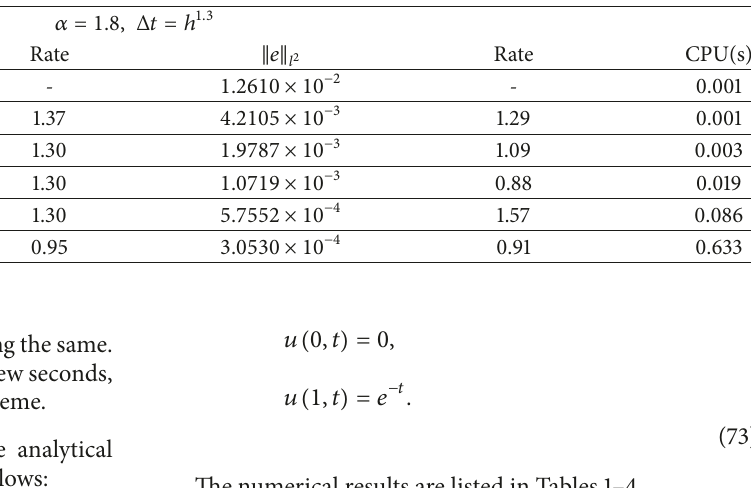
Table 12: Error and convergence rates for Example 2 by